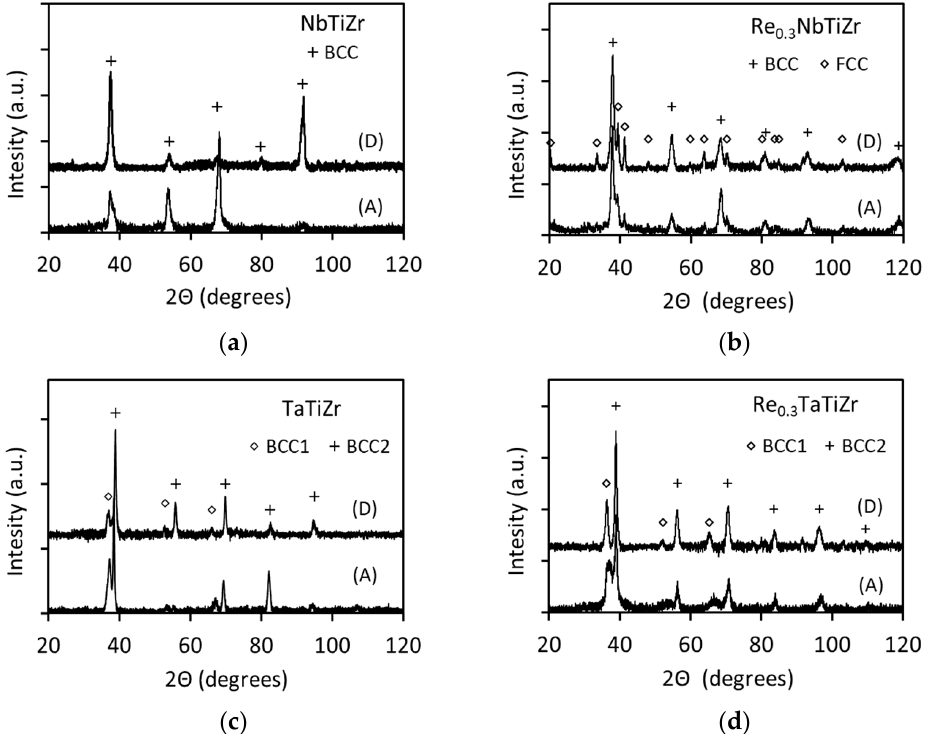
Figure 3. X-ray diffraction patterns of the studied alloy samples in (A) HIP’d at 1400 °C and slow cooled condition or (D) deformed at 1000 °C to 0.69 true strain and slow cooled conditions: ( a )